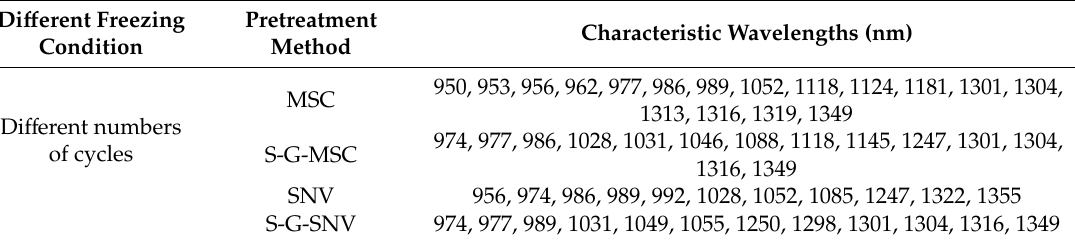
Table 5. The extraction values of the characteristic wavelengths for di ff erent numbers of